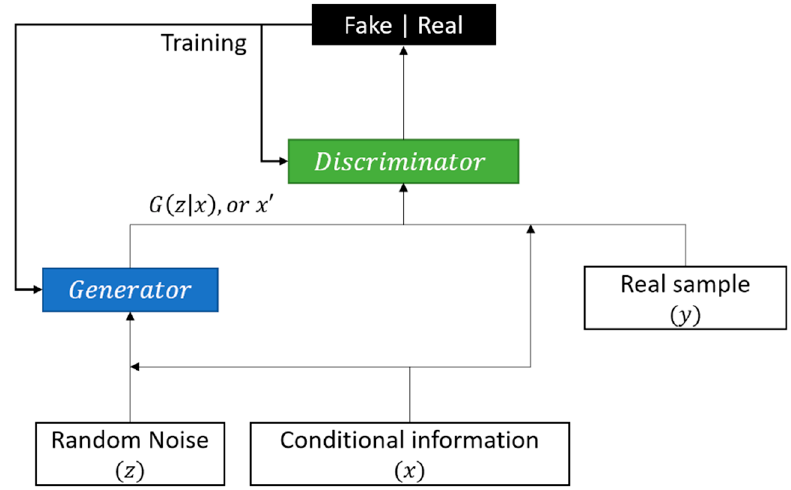
Figure 1. Simplification of the training procedure of a cGAN model. Note: In cGANs, we explicitly define x as an additional input to G ( z ) , resulting G ( z | x ) , and as additional input to D ( y ) , resulting D ( y | x )